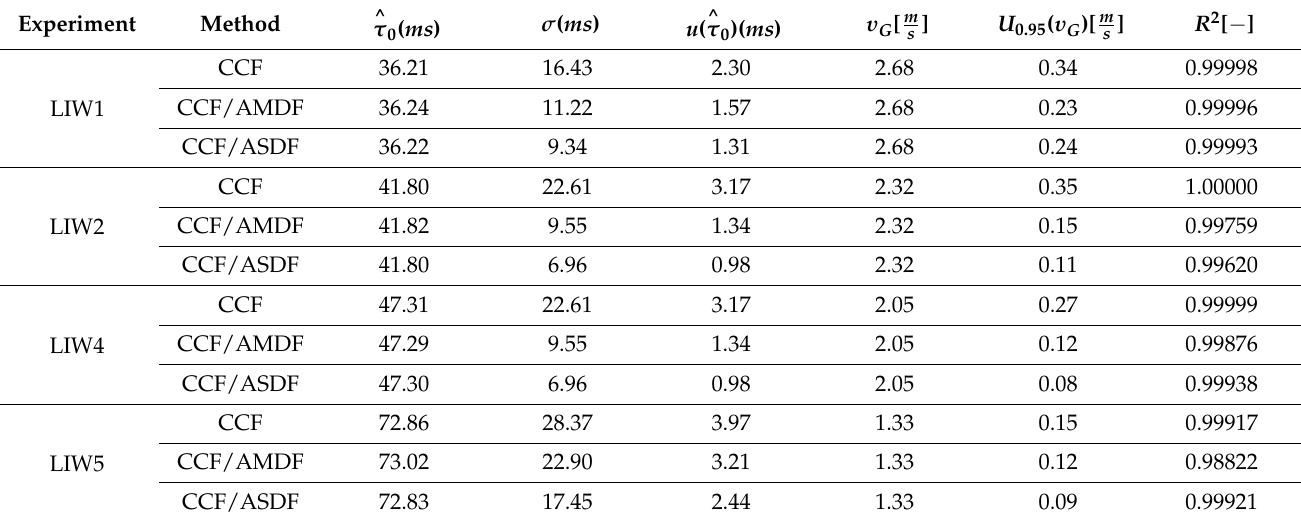
Table 3. The results of measurements obtained in the LIW experiments.